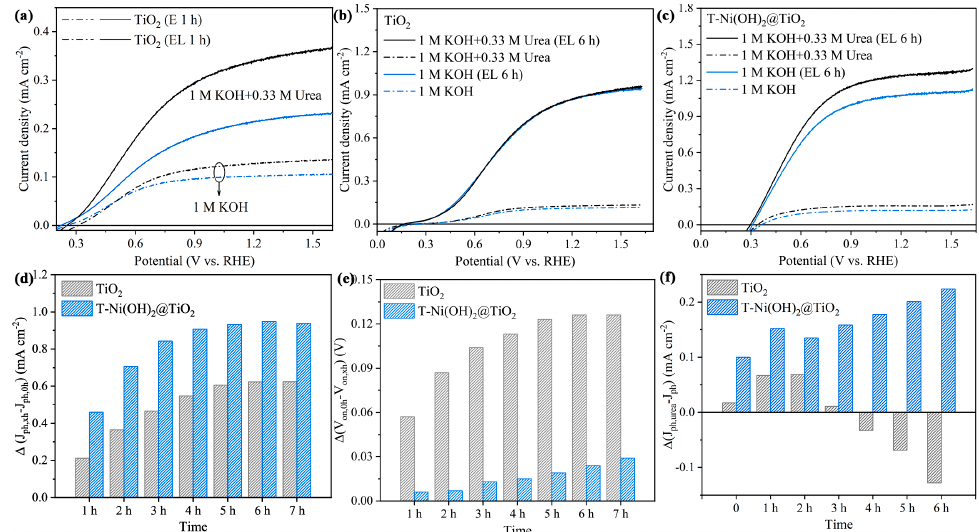
Figure 5. ( a ) LSV curves of TiO 2 photoanodes subjected to 1 h E and 1 h EL treatments. ( b ) LSV curves of TiO 2 photoanodes with/without 6 h EL treatment measured in 1 M KOH or 1 M KOH/0.33 M urea. ( c ) LSV curves of T-Ni(OH) 2 @TiO 2 photoanodes with/without 6 h EL treatment measured in 1 M KOH or 1 M KOH/0.33 M urea. ( d ) The increment of photocurrent density ( Δ (J ph,xh − J ph,0h )) of TiO 2 and T-Ni(OH) 2 @TiO 2 photoanodes. ( e ) The negative shift of the onset potential ( Δ (V on,0h − V on,xh )) of TiO 2 and T-Ni(OH) 2 @TiO 2 photoanodes. ( f ) The difference values of the urea splitting J ph,urea and water splitting J ph ( Δ (J ph,urea − J ph )). Scan rate: 20 mV s − 1 . Illumination: AM 1.5 G illumina-